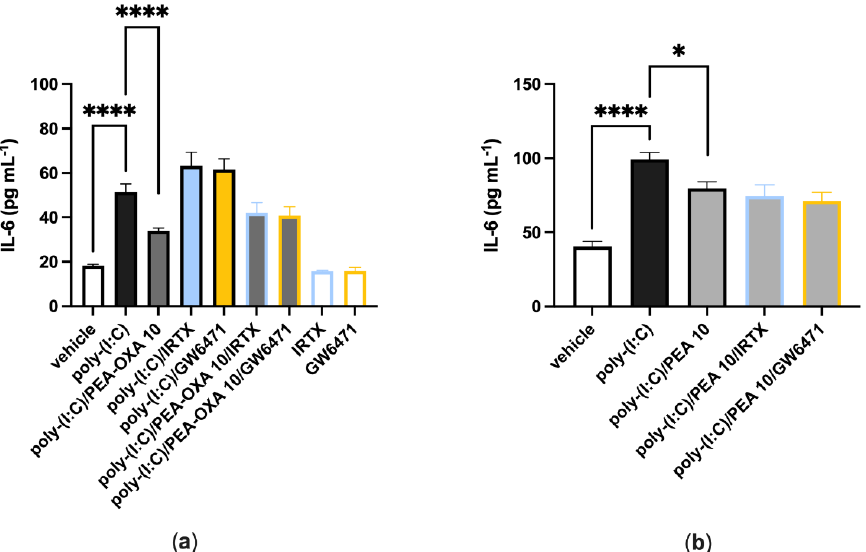
Figure 3. TRPV1 and PPAR-  antagonists do not revert the anti-inflammatory effect of PEA-OXA and PEA in poly-(I:C)-stimulated A549 cells. ( a ) IL-6 release was measured after that A549 cells were stimulated with poly-(I:C) (100 μg mL -1 ) and treated with IRTX (0.1 μM) or GW6471 (1 µM) in the presence or absence of PEA- OXA (10 μM), for 6 h at 37 °C in a 5% CO 2 atmosphere; ( b ) IL-6 release was measured after A549 cells were stimulated with poly- (I:C) (100 μg mL -1 ) and treated with IRTX (0.1 μM) or GW6471 (1 µ M) in the presence or absence of PEA (10 μM), for 6 h at 37 °C p -values were determined by ANOVA followed by Tukey’ s multiple comparisons